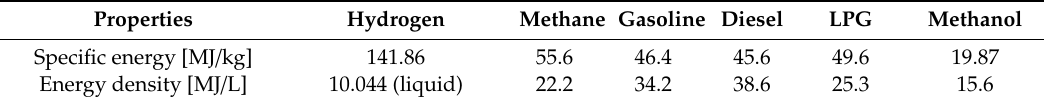
Table 1. Specific energy and energy density comparison between hydrogen and other fuels.